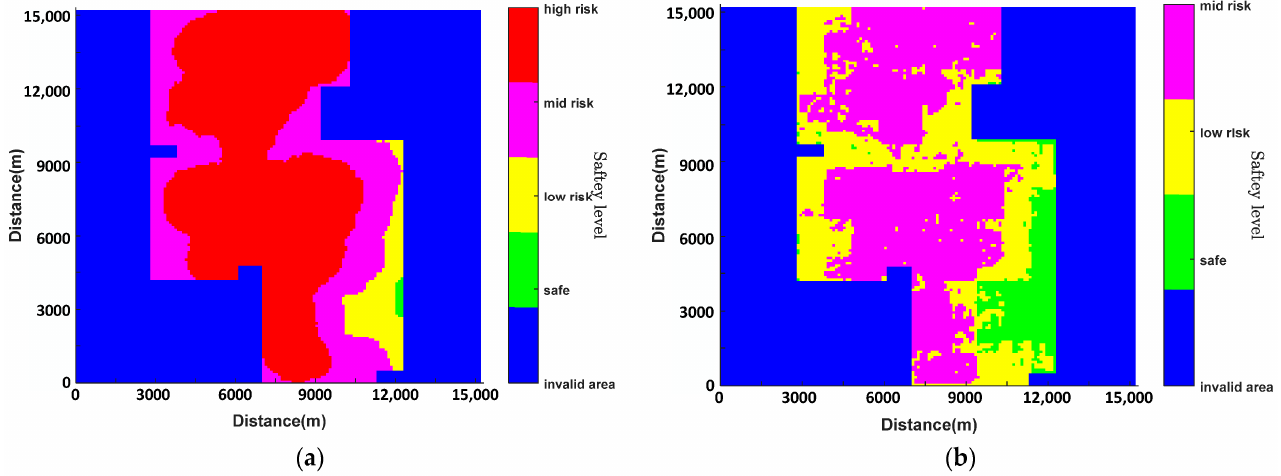
Figure 8. Risk layers. ( a ) Layer for Talon; ( b ) Layer for DJI Inspire 2. The left one is the risk layer for Talon and the right one is for DJI Inspire 2. It is reasonable that the patterns in the two layers are in a similar shape. Because of the hazard event corresponding to UA’s ballistic descent, the hazard areas were always regions with dense populations and sparse shelters, such as the center of the target area on the map. The safety areas were always regions with sparse populations and dense shelters, such as the bottom right corner of the target area. Compared with the risk layer for the Talon, the grids in the risk layer for DJI Inspire 2 are generally assessed with a lower safety level